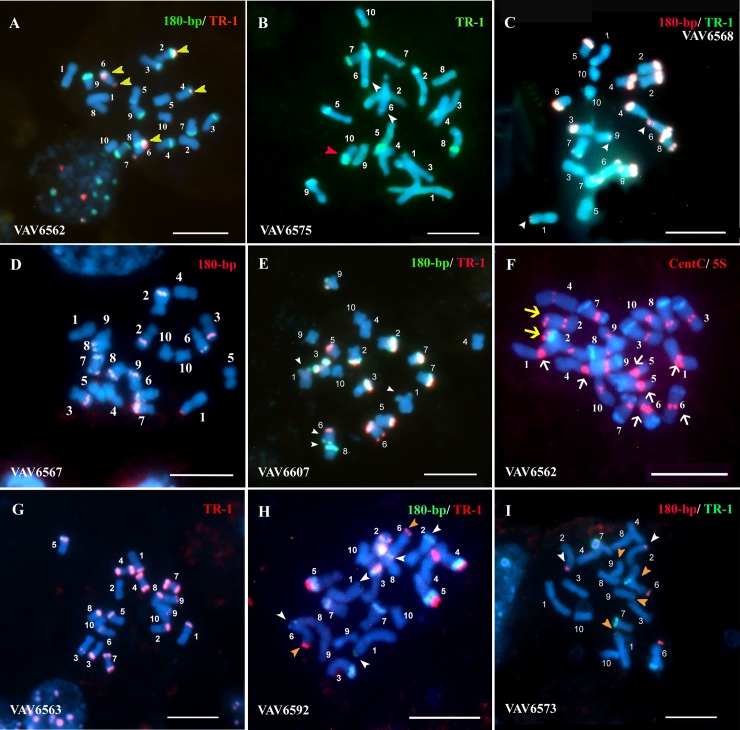
Characterization of Popcorn and F-Pc Guaraní maize metaphase chromosomes by FISH with knobs, CentC and 5S rDNA probes.(A-I) merge DAPI (blue) / FISH. (A) and (F) VAV6562, Pororó Grande. (B) VAV6575, Pororó Chico. (C) VAV6568, Pipoca Amarillo. (D) VAV6567, Pipoca Colorado. (E) VAV6607, Pipoca Colorado. (G) VAV6563, Tupí Amarillo. (H) VAV6592, Tupí Blanco. (I) VAV6567, Colorado. Ref. The white arrowhead indicates knobs hybridized only with 180-bp sequence. The orange arrowhead indicates knobs hybridized only with TR-1 sequence. The red arrowhead indicates a chromosome with AB10 morphology. The yellow arrow indicates 5S rDNA hybridization signal. The white arrows indicate the most intense and / or higher hybridization signals of CentC sequence. The numbers indicate the chromosomal pairs. Scale bars = 10 μm.